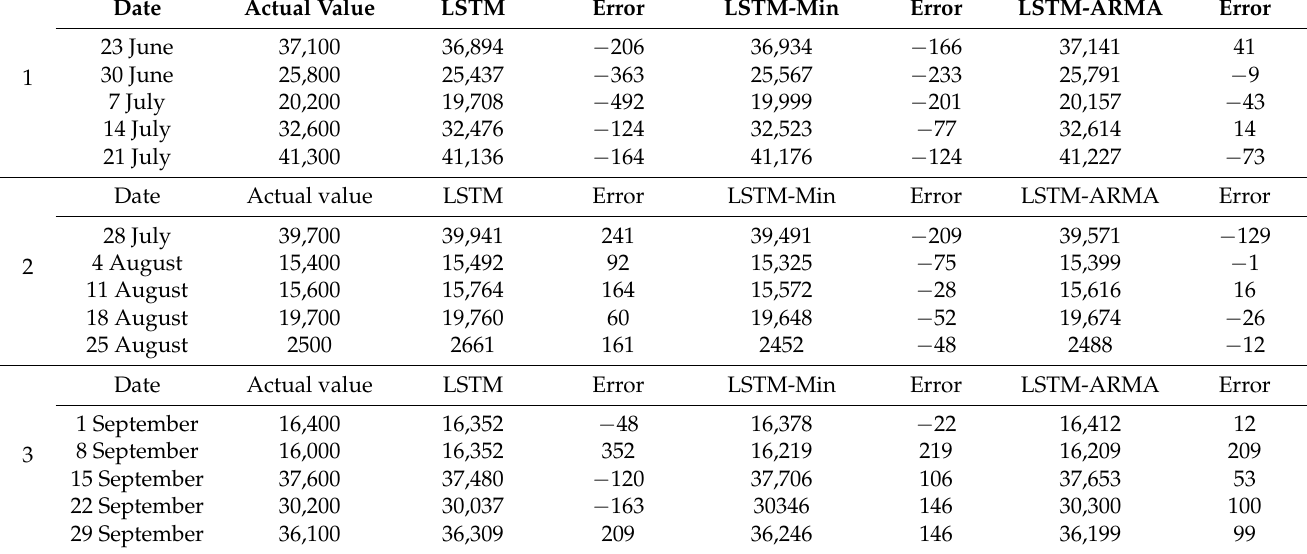
Table 5. BGA 11.5X13 rolling forecast results summary.